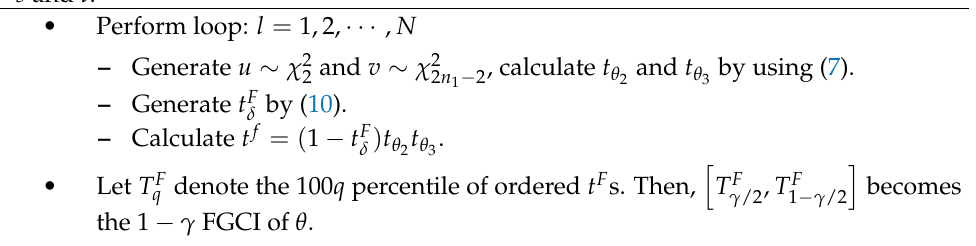
Algorithm 3: For a given sample, determine n 0 and n 1 , and calculate